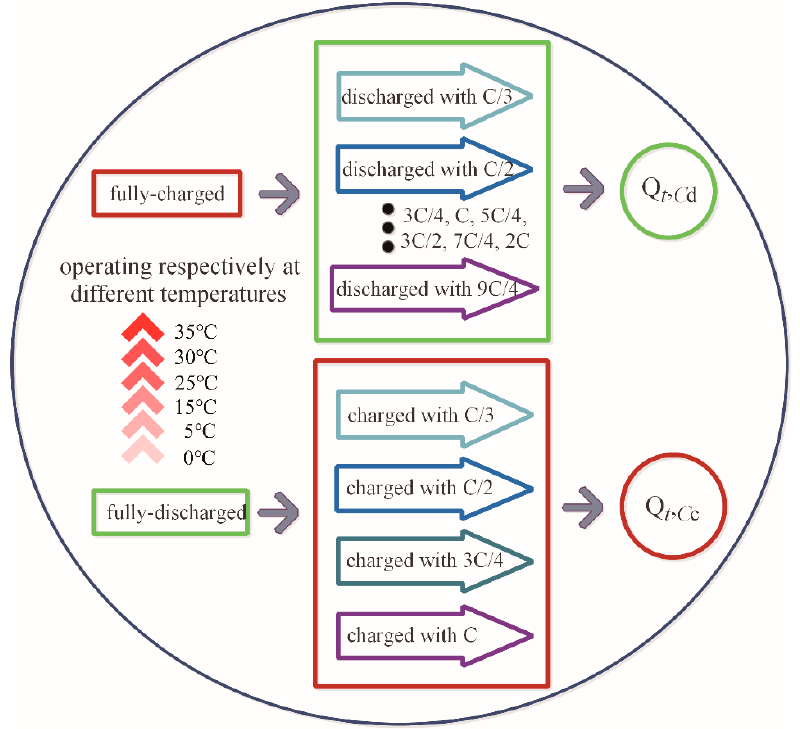
Figure 3. Scheme of discharging–charging capacity test at different temperatures in the range 0–35 °C and